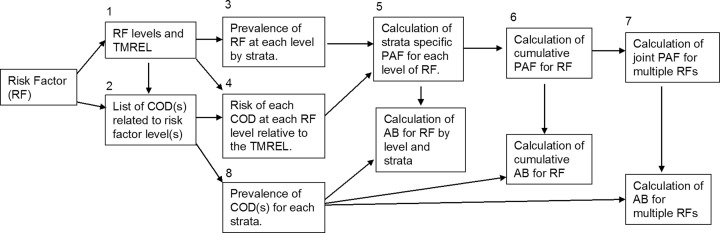
Conceptual model of the steps needed to estimate the GBD. AB, attributable burden; COD, cause(s) of death; GBD, Global Burden of Death study; PAF, population attributable fraction; TMREL, theoretical minimum risk exposure level.